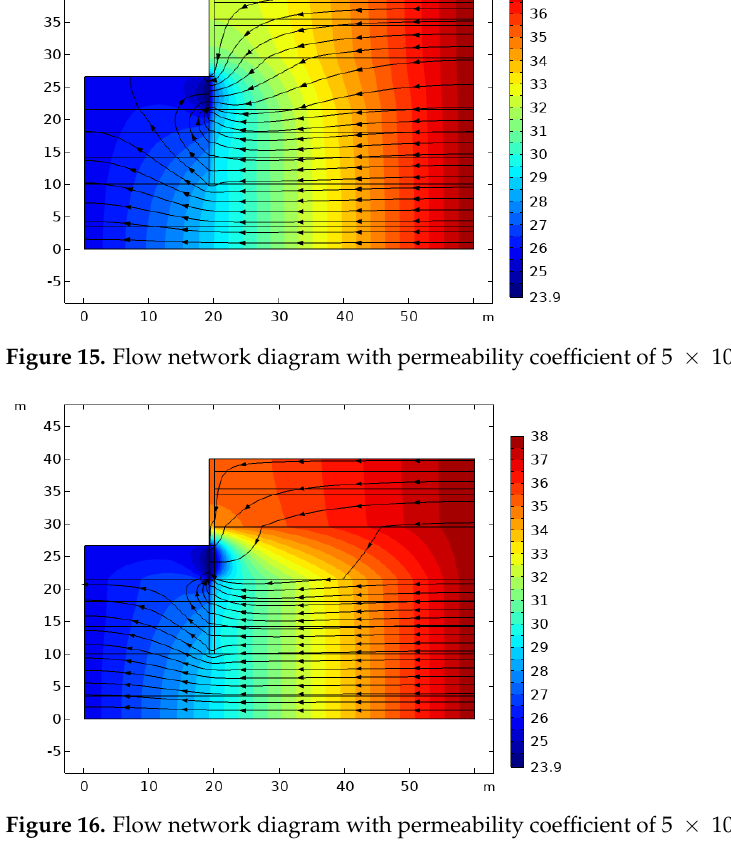
Figure 16. Flow network diagram with permeability coefficient of 5×10 -2 m·d -1 .